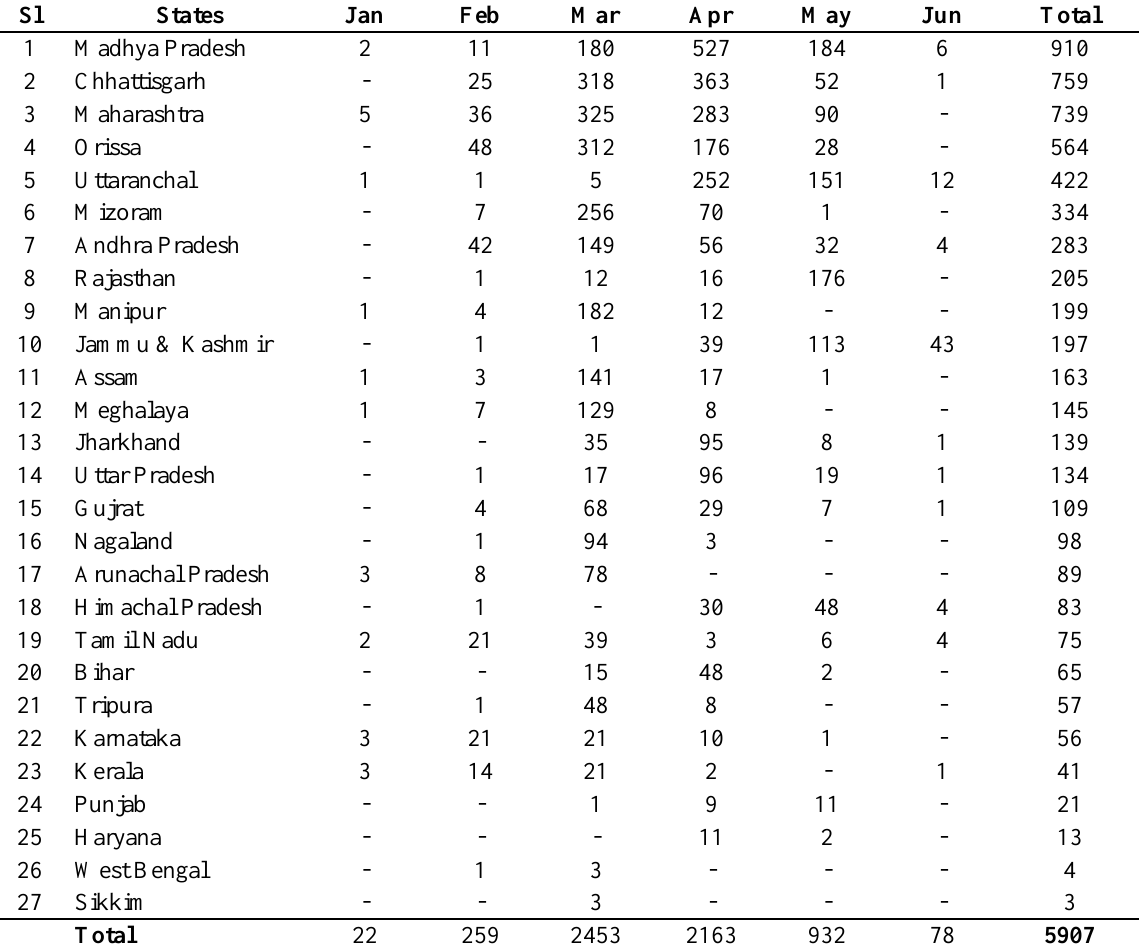
Table 1. Observation of fire occurrences in different states using A(A)TSR night-time data between 1997 and 2005 for the months of January to June.